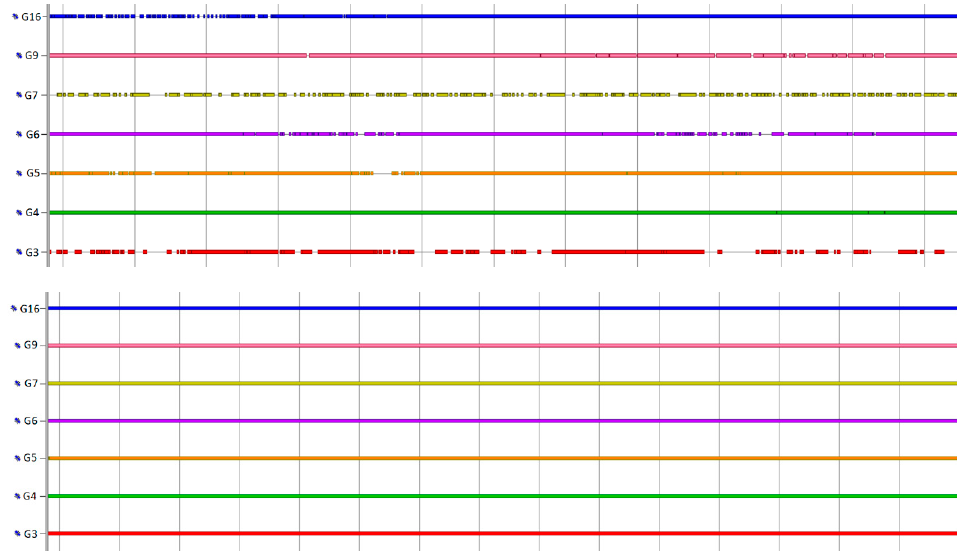
Figure 2. Comparison of data quality collected by GEO++ RINEX Logger (upper) and RINEX ON (bottom).